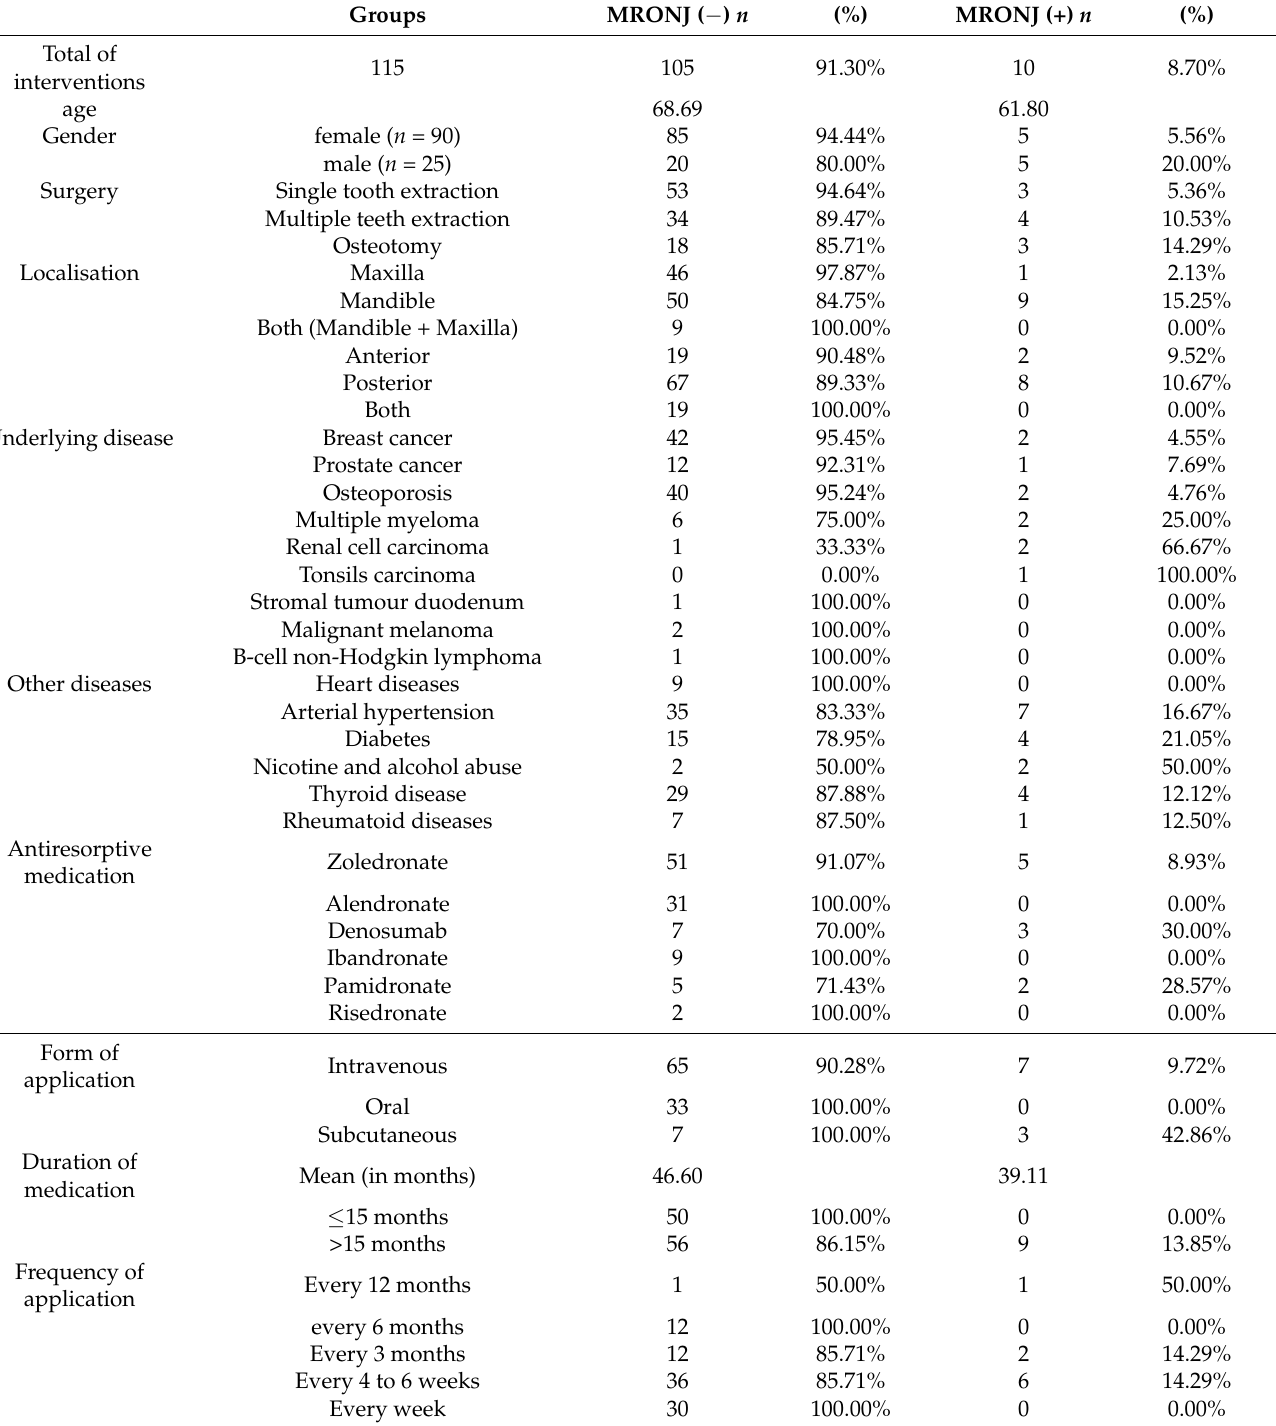
Table 1. Illustration of the patient cohort with n = 115 dentoalveolar interventions and relation to MRONJ+ occurrence with n = 10 from the total